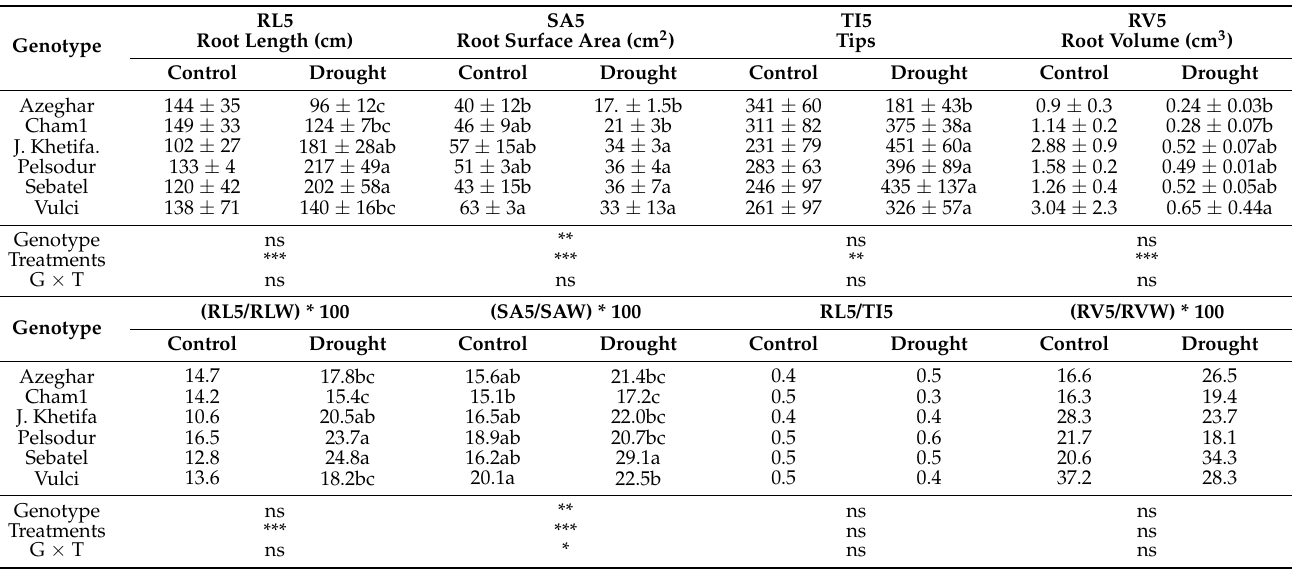
Table 3. Root characteristics at a depth of the first 5 cm below ground in greenhouse